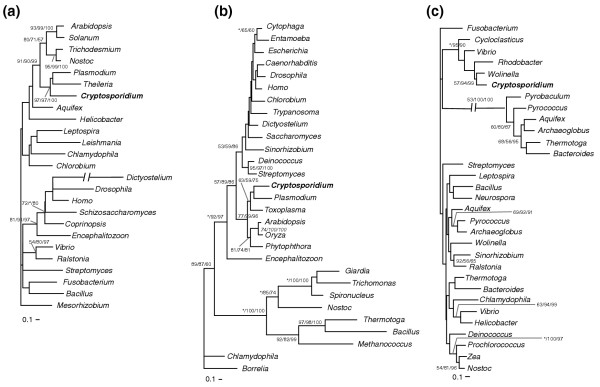
Phylogenetic analyses. (a) Leucine aminopeptidase; (b) glucose-6-phosphate isomerase; (c) tryptophan synthetase β subunit. Numbers above the branches (where space permits) show the puzzle frequency (with TREE-PUZZLE) and bootstrap support for both maximum parsimony and neighbor-joining analyses respectively. Asterisks indicate that support for this branch is below 50%. The scale is as indicated. GI accession numbers and alignments are provided in Additional data file 1.